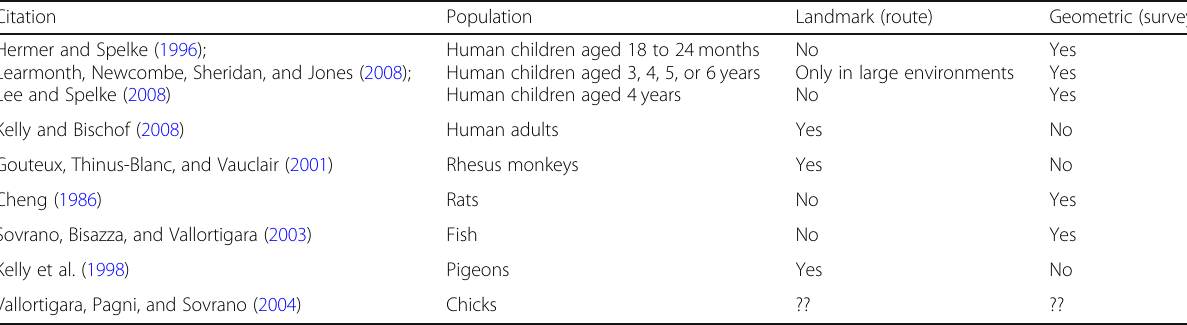
Table 1 Spatial reorientation Cue Conflict results across multiple species